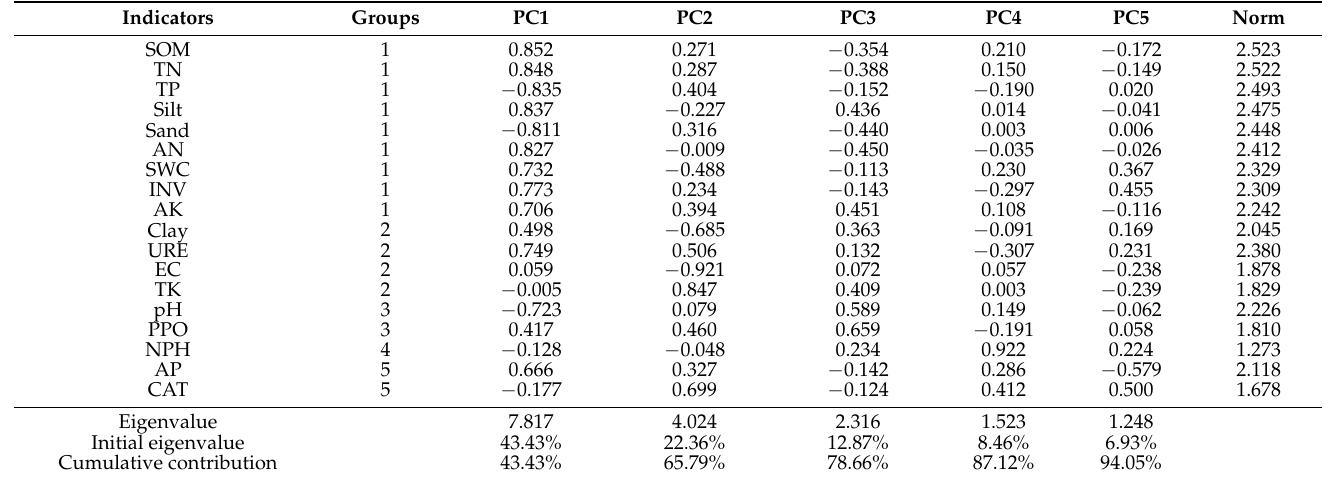
Table 3. Principal component analysis results and factor load matrix.